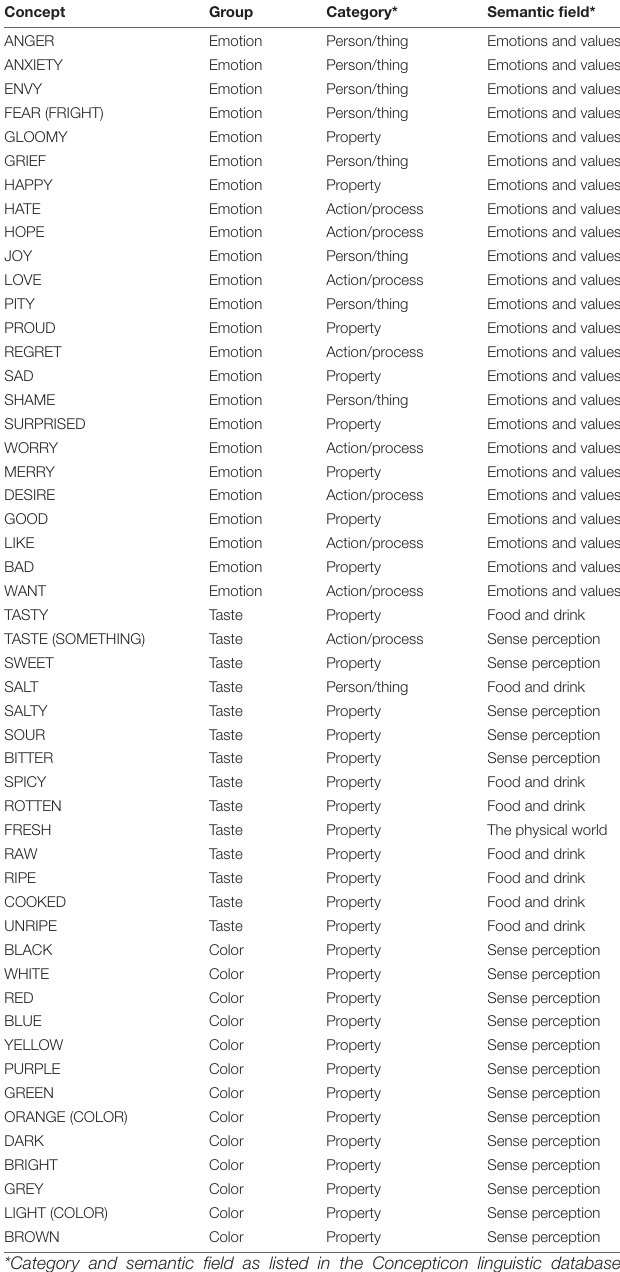
TABLE 2 | Emotion, Taste a , and Color concepts. Concept